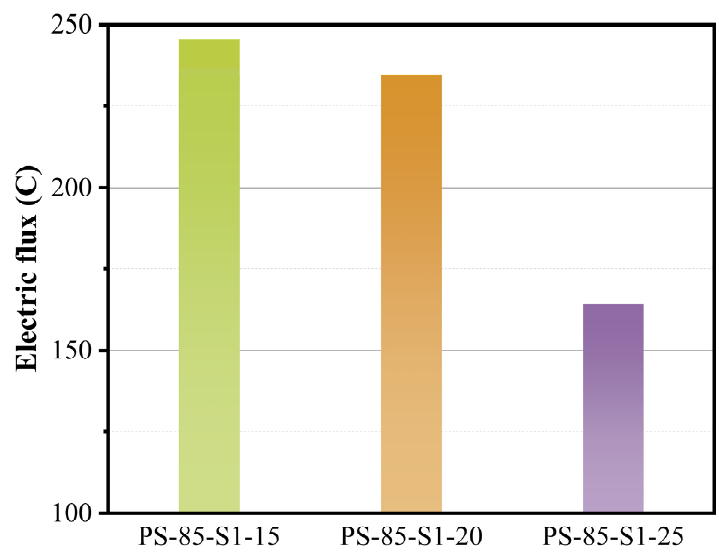
Figure 5. The electric fluxes of WUFA-PS geopolymer mortars with different activator dosages.